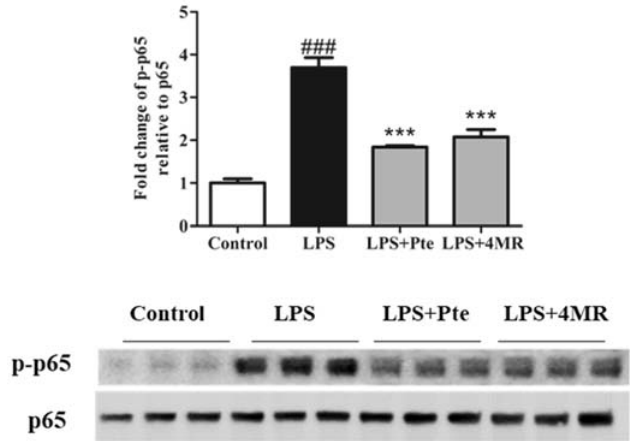
Figure 5. Effect of Pte and 4MR on LPS-induced p-p65 protein expression in RAW264.7 cells. Cells were cotreated with both LPS (0.1 µ g/mL) and Pte (5 µ M) or 4MR (5 µ M) for 30 min. The protein expression levels were measured by Western blot. The data were representatives of three independent experiments and presented as the mean ± SEM. ### p < 0.001 compared to control; *** p < 0.001 compared to LPS alone.